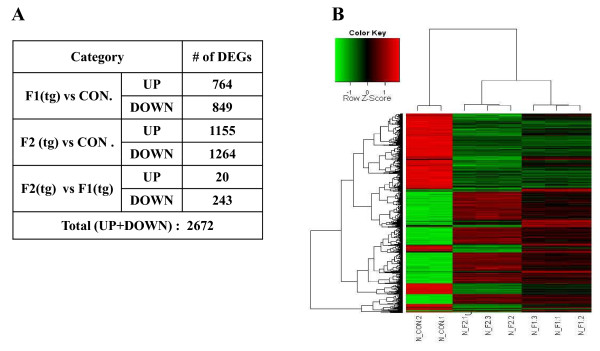
Microarray image and data analysis. A. Statistical significance of each correlation coefficient was determined using a corrected (Benjamini & Hochberg algorithm) P value (P
< 0.05). B. Heat map and cluster analysis of gene expression measurements normalized to a single array showing genes in rows and samples in columns. Columns 1, 2: control mice; columns 3, 4, 5: F2 (tg); columns 6, 7, 8: F1 (tg); Con, control; tg, transgenic.